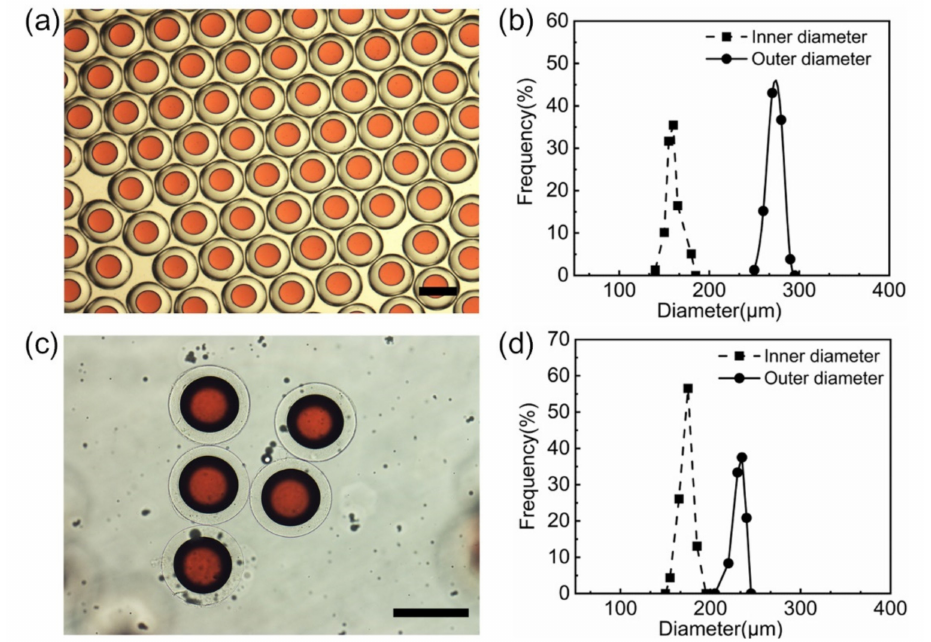
Figure 6. Preparation of O/W/O emulsions and alginate microcapsules by pre-mixing method. Optical micrographs ( a ) and the size distribution of O/W/O emulsions ( b ). The resultant alginate microcapsules 1% ( w / v ) CaCl 2 solution ( c ) and the corresponding size distribution ( d ). Scale bars are 200 µ